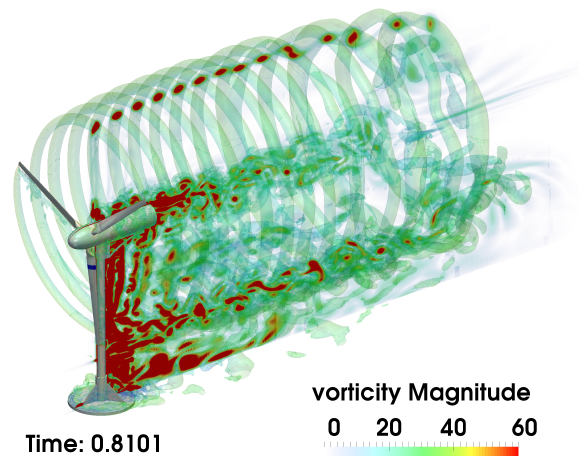
Figure 8. Vorticity visualization for the DDES turbulent simulation.